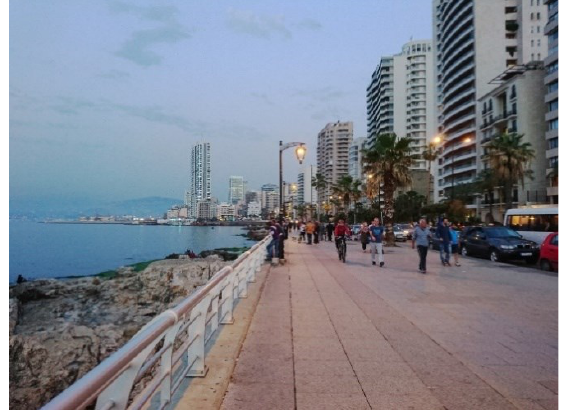
Figure 2 . The Corniche Beirut, a seaside public walkway facing high-end buildings (adapted from Maria A. El Helou photo archive)